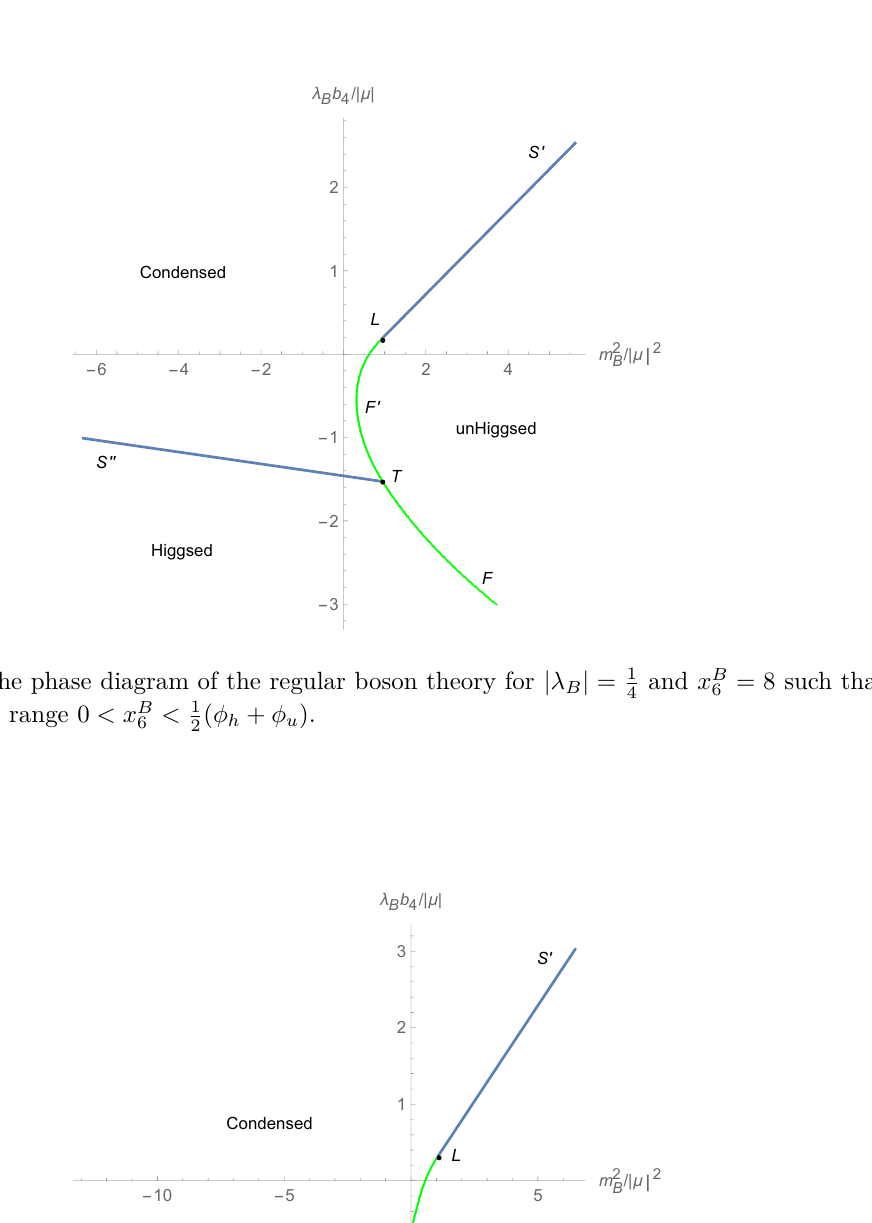
( φ h + φ u ) < x B < φ u 6 2